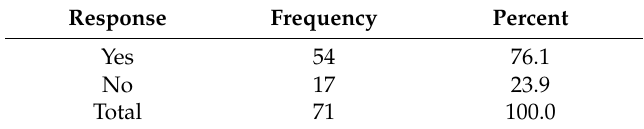
Table 6. The response to whether the respondent is willing to assist the police in carrying out their duties.